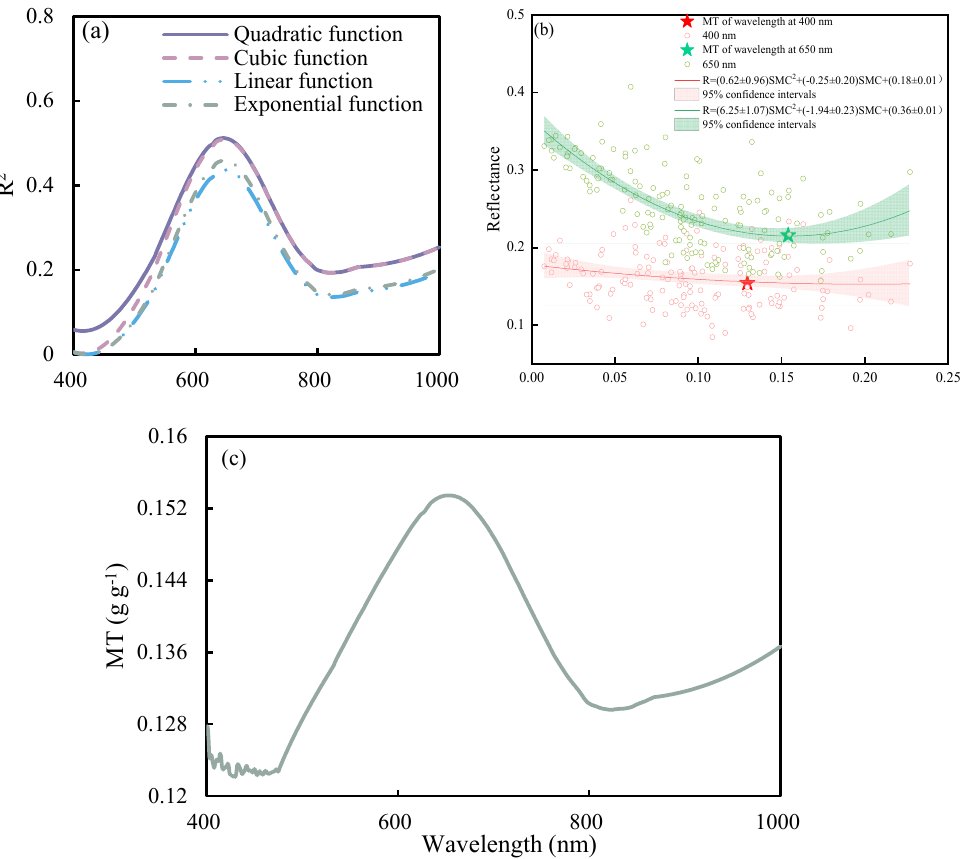
Figure 8. Relationship between SMC and spectral reflectance: ( a ) fitting R 2 of spectral reflectance and SMC by different functions; ( b ) spectral reflectance variation with SMC at the wavelength 400 and 650 nm; ( c ) MT value of each band.